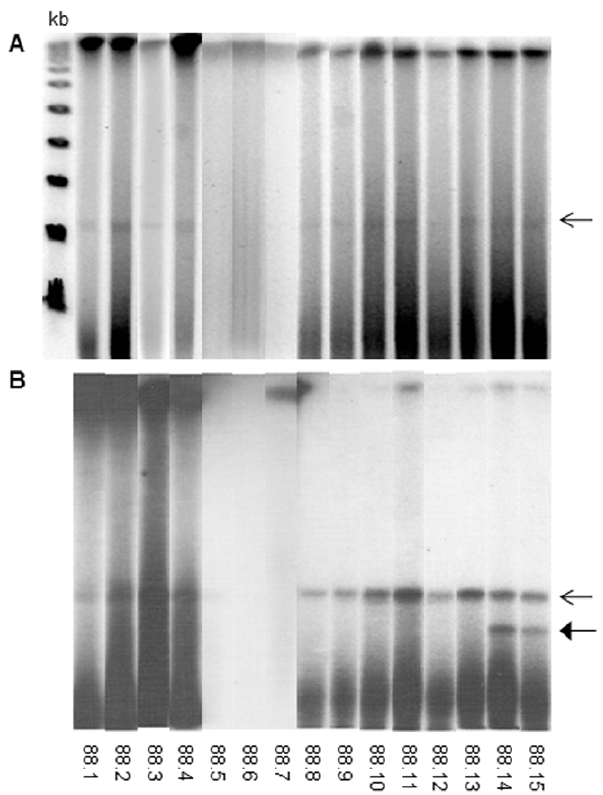
Figure 1. PFGE and Southern blot hybridization with IS 1245 - derived probe of M.avium and M.kansasii colonies. (A) PFGE with undigested DNA; (B) Southern blot hybridization with IS 1245 -derived probe. Open arrow indicates pMA100; closed arrow indicates the uncharacterized smaller hybridization band. 88.1 to 88.4= M . avium ; 88.5 to 88.75 = PCR 2 IS 1245- negative M . kansasii ; 88.8 to 88.15=PCR 2 IS 1245- positive M. kansasii. On the left, Lambda Ladder PFG Marker (NewEngland BioLabs) molecular size